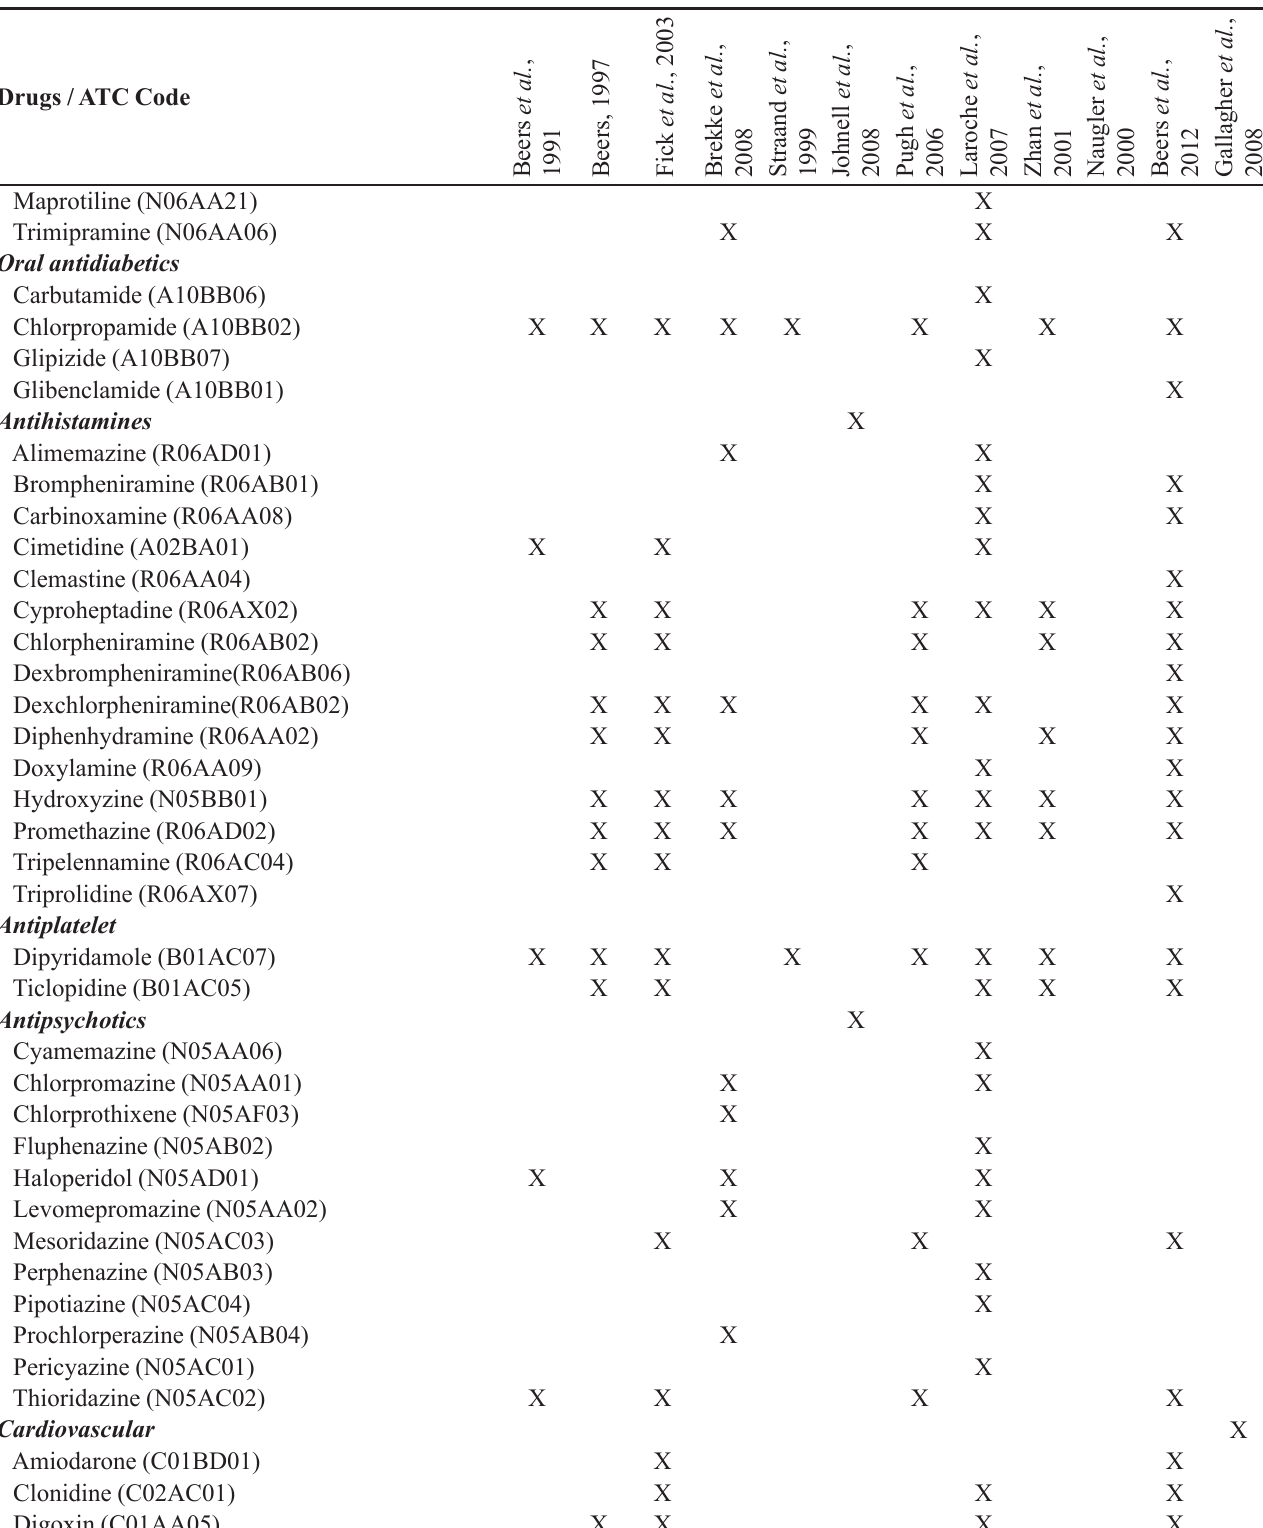
TABLE I - List of potentially inappropriate medications (PIM) for the elderly that should be avoided irrespective of diagnosis or clinical condition, according to the methods identified in PAHO (available in: http://regional.bvsalud.org/php/index.php), Lilacs and Pubmed databases, during the period between February and March 2010 (n=12)